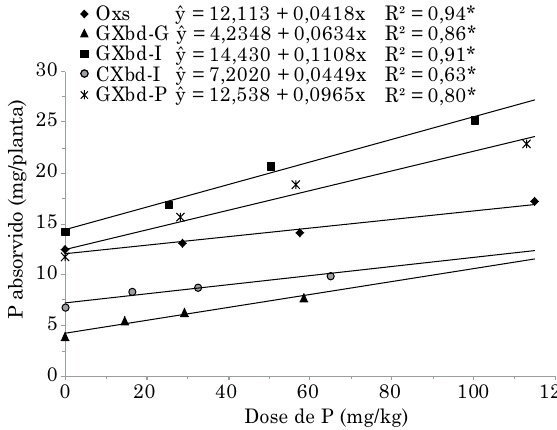
figura 1. fósforo absorvido pelas plantas de arroz irrigado nos diferentes solos de santa catarina em função da aplicação de doses de P. oXs: organossolo Háplico sáprico típico - Jaguaruna; gXbd-g: gleissolo Háplico tb distrófico típico - Gaspar; GXbd-I: Gleissolo Háplico tb distrófico típico - Itajaí; cXbd-i: cambissolo Háplico tb distrófico típico - itajaí; e cXbd-P: cambissolo Háplico tb distrófico típico - Pouso redondo. *: significativo a 5